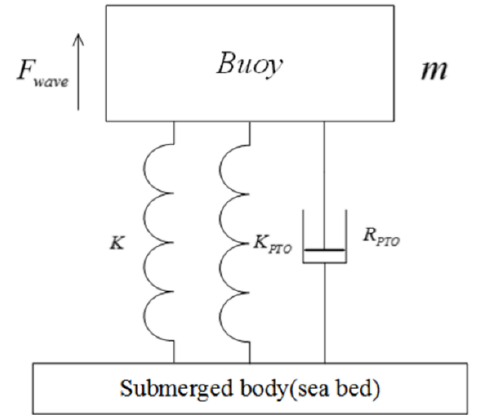
Figure 1. Equivalent schematic diagram of point absorber.